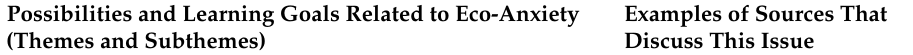
Table 1. Possibilities and learning goals related to eco-anxiety for pastoral